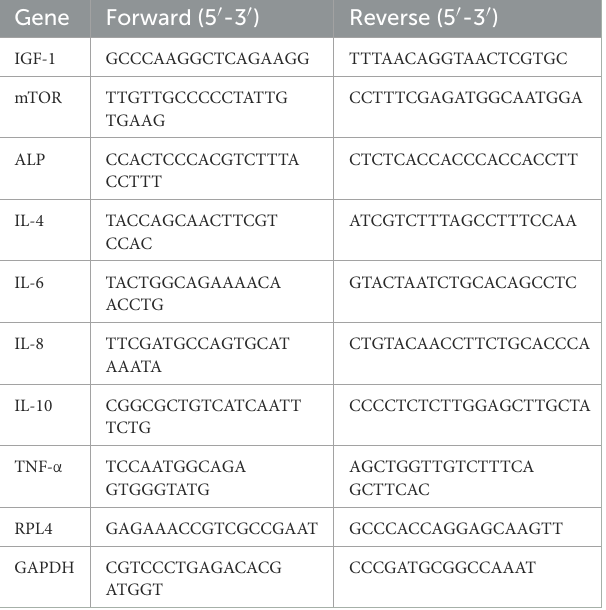
TABLE 1 Sequences of the primers used for quantitative real-time PCR analysis.